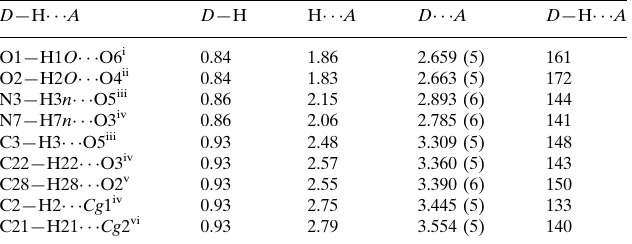
Data collection Bruker SMART APEX diffractometer Absorption correction: multi-scan ( SADABS ; Sheldrick, 1996)